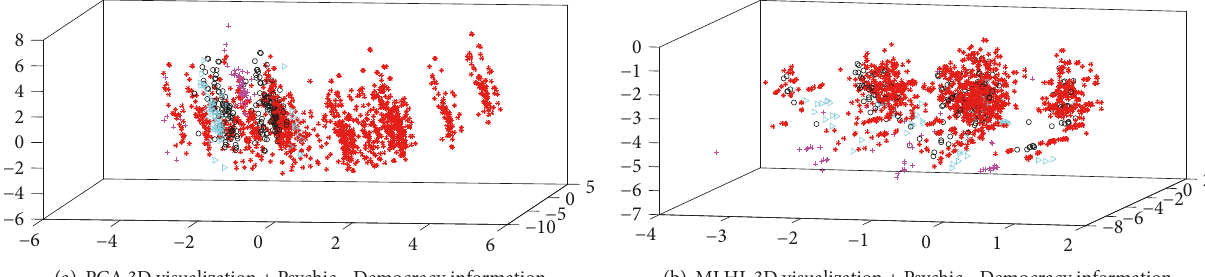
(b) MLHL 3D visualization + Psychic - Democracy information Figure 11: 3D plots from EPP methods.